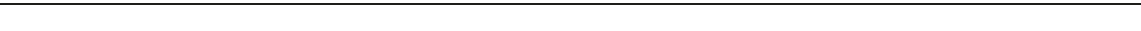
Fig. 5 Ino80 depletion results in faulty endothelial cell sprouting and migration. a , b Schematics, confocal images, and quanti fi cations of sinus venosus and endocardial angiogenesis assays. Arrows indicate direction of endothelial cell sprouting. Endothelial cells are labeled with ERG and either VE-cadherin ( a ) or through Nfatc1Cre lineage tracing ( Nfatc1Cre -line) ( b ). Images are representative of the following number of replicates: sinus venosus (control, n = 5